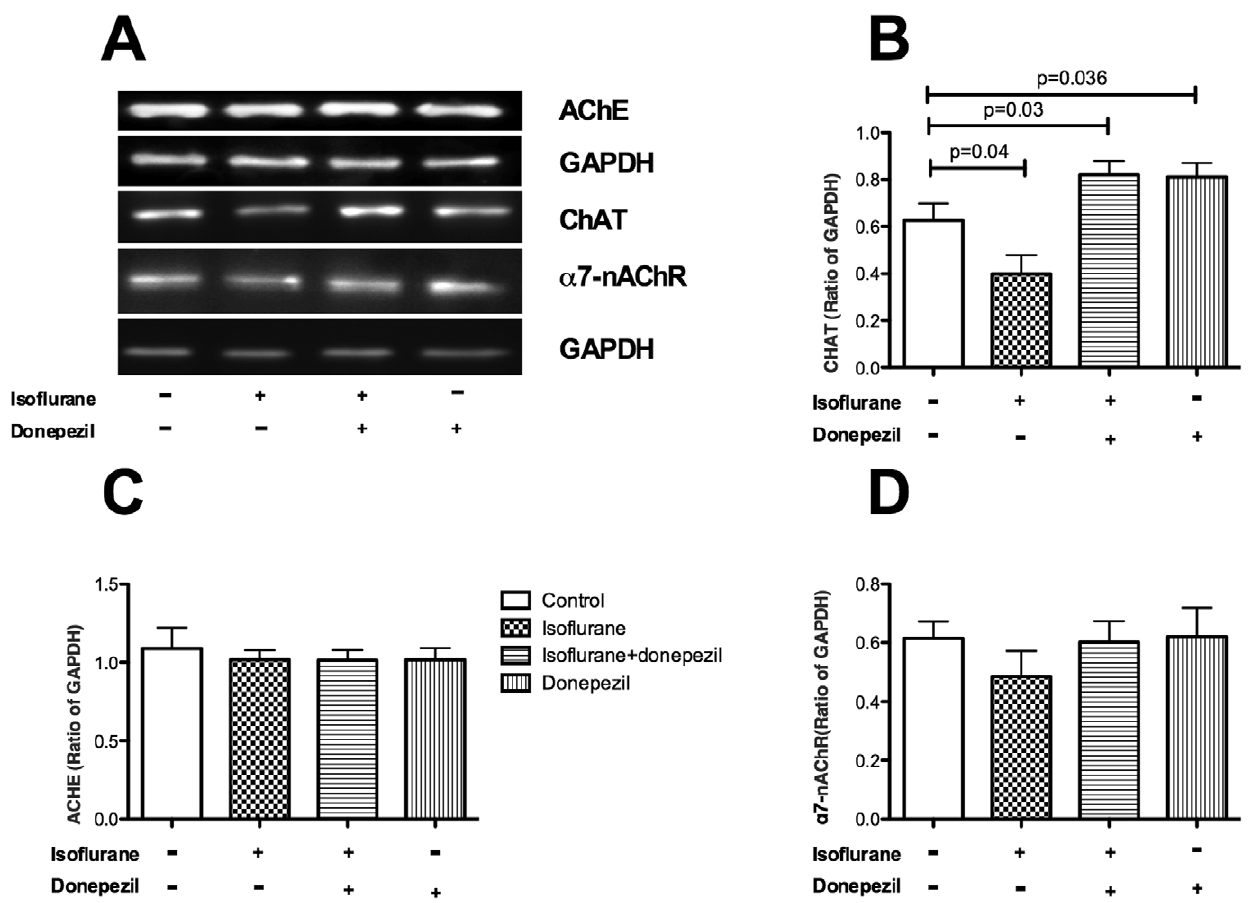
Figure 2. Donepezil pretreatment increased the expression of ChAT which was decreased by isoflurane exposure. A: Isoflurane exposure decreased ChAT levels, and donepezil increased the expression of ChAT, as detected using Western blotting. B: Statistical analyses demonstrated significant differences in ChAT expression among the four groups. C: We did not observe any differences in AChE levels among the four groups. D: In addition, we did not observe any differences in a 7-nAChR levels among the four groups. ChAT: choline acetyltransferase; AChE: acetylcholinesterase; a 7-nAChR: a 7-nicotinic acetylcholine receptor. N=10 in each group.